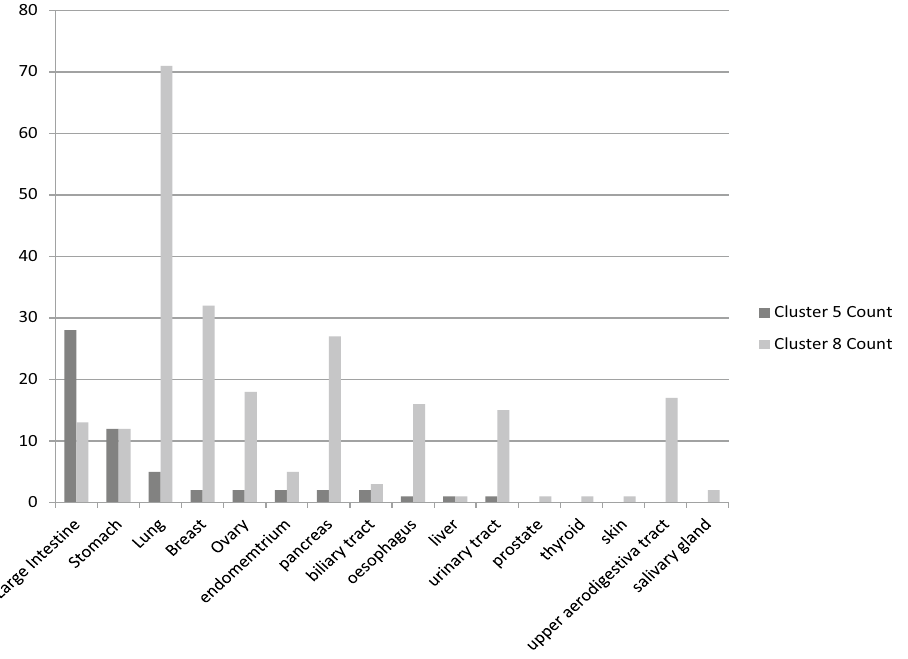
Figure 3. Distribution of the cancer tissues in cluster 5 and cluster 8. All cancer tissues in cluster 5 are also present in cluster 8 but cluster 8 also contains some cancer tissues that are not a member of cluster